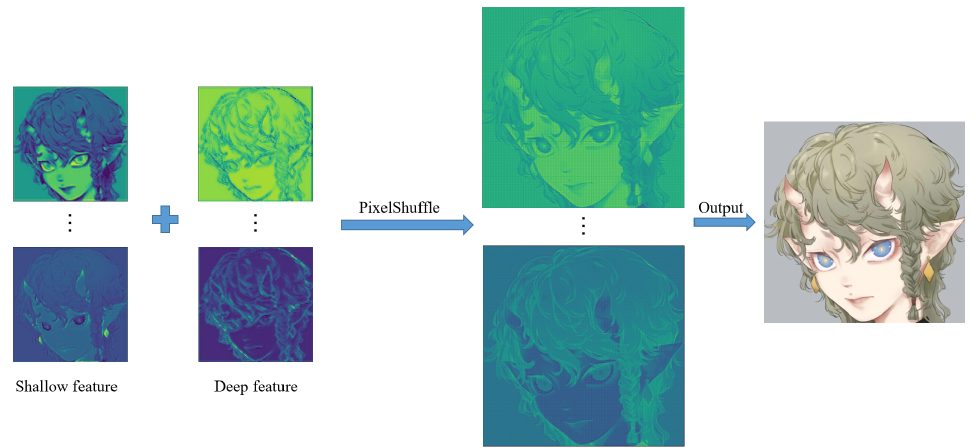
Figure 15. An upsampling example of reconstruction